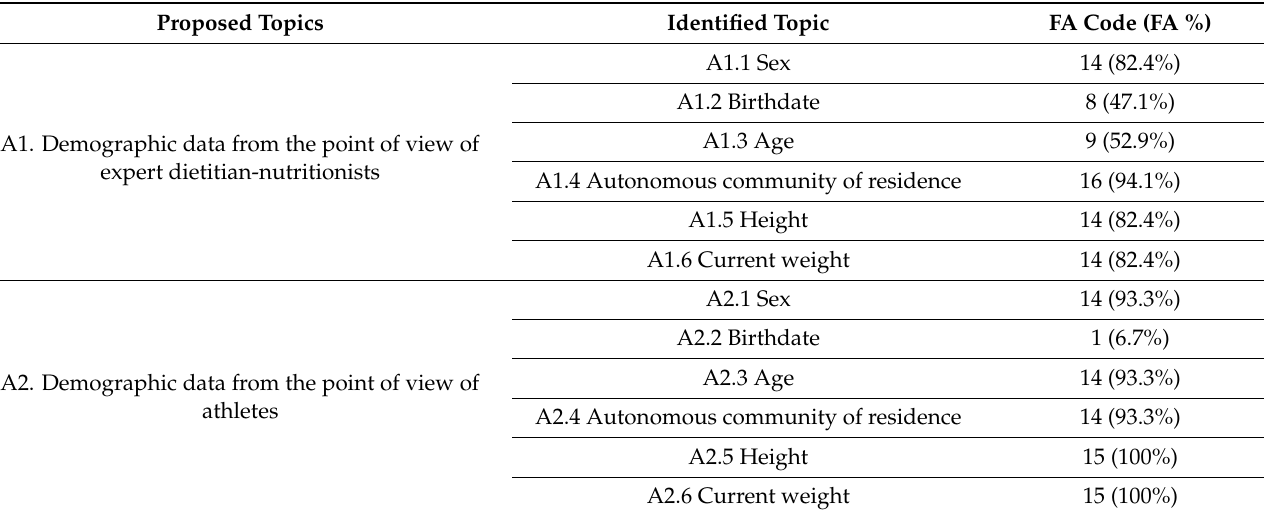
Table 1. Results of the focus groups for the content of part I of the questionnaire, related to the demographic data of the